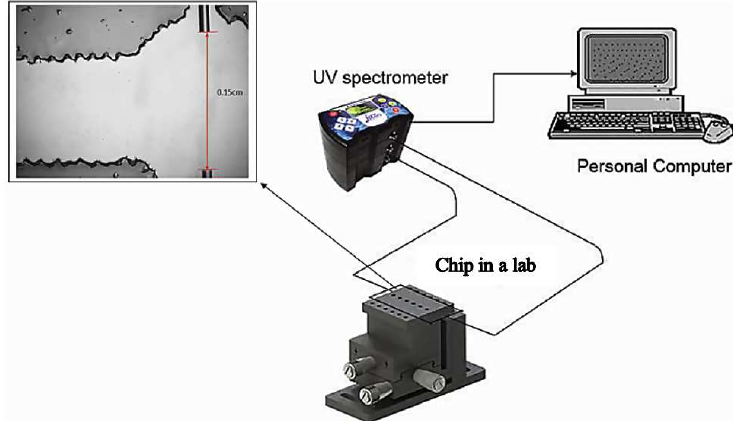
Figure 3. Fibre alignment setup using UV spectrometer and ball bearing vertical linear stages.